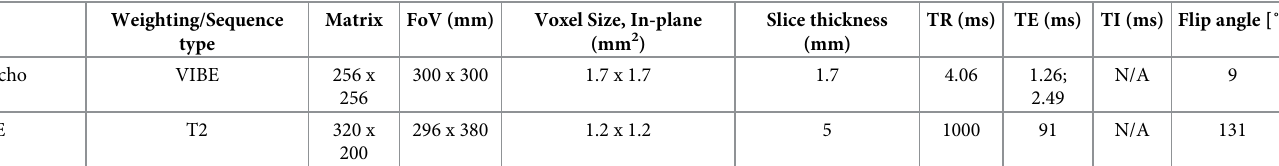
Table 1. Parameters of the acquired sequences.